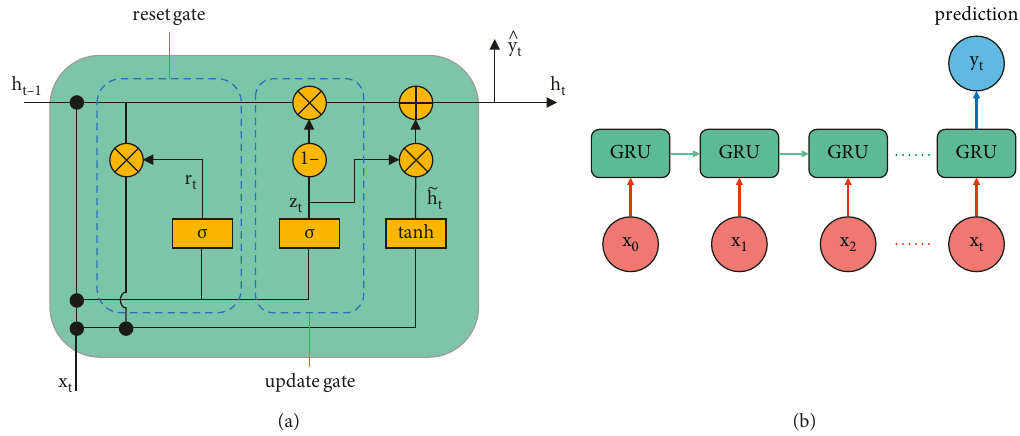
Figure 1: The structure of GRU for sequence prediction. (a) The structure of GRU. (b) Sequence prediction using